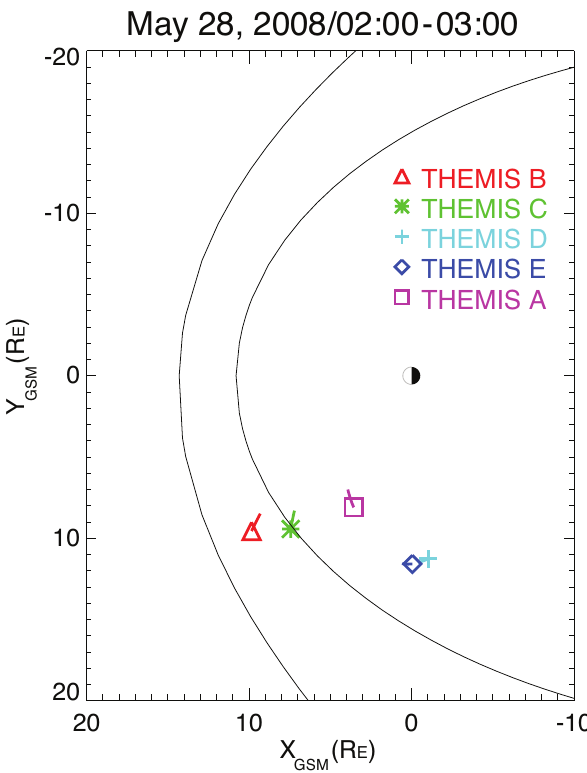
Fig. 2. THEMIS trajectories (small colored lines) projected in the GSM X-Y plane from 02:00 to 03:00UT on 28 May 2008. The two black curves represent the location of the bow shock and magne- topause determined by the Fairfield model (Fairfield, 1971). The positions of 5 THEMIS probes at 03:00UT are marked by 5 dif- ferent symbols. THEMIS B and C are in the magnetosheath and THEMIS D, E, and A are inside the magnetosphere at 02:20UT, which can be identified from the ion spectra in Fig. 3d, h, j, l and n. THEMIS D and E are very close to each other on the dusk flank. At 02:25UT, THEMIS B is located at (9.5, 8.9, − 3.5)GSM R E , THEMIS C is located at (7.3, 8.8, − 1.9)GSM R E , THEMIS A is located at (3.8, 7.5, − 1.1)GSM R E , THEMIS D and E are lo- cated at ( − 0.7, 11.4, 0.6)GSM R E and (0.3, 11.6, 0.2)GSM R E ,